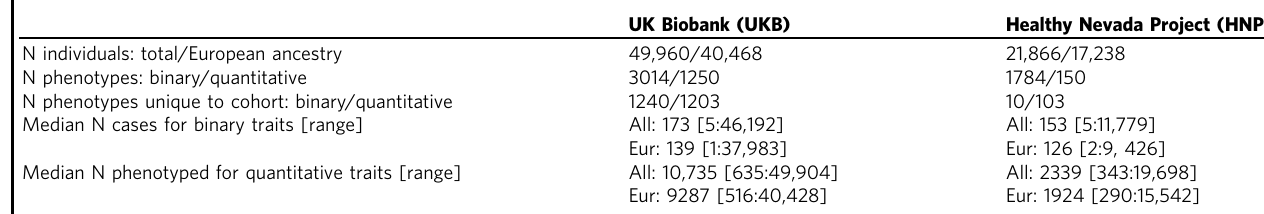
Table 1 Study and cohort